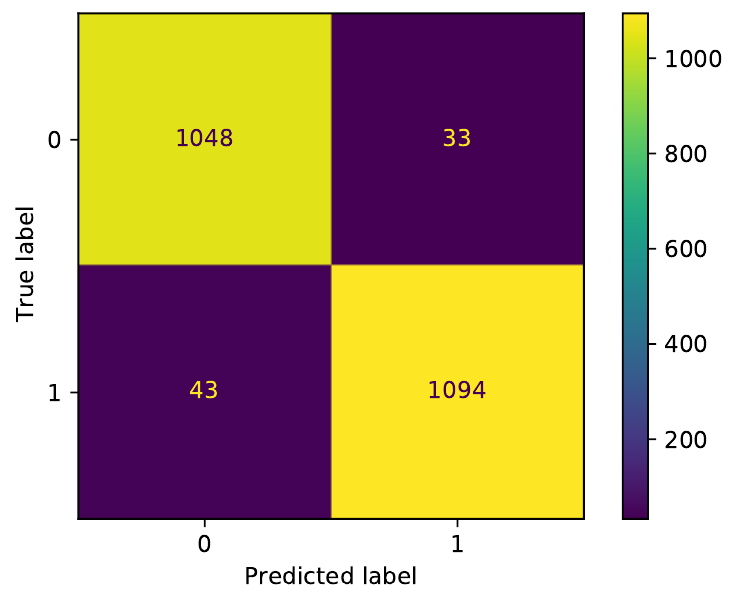
Figure 5. ROC-AUC curve for the proposed algorithms. SVM has the highest AUC value, whereas decision trees and linear regression have equal AUC values.